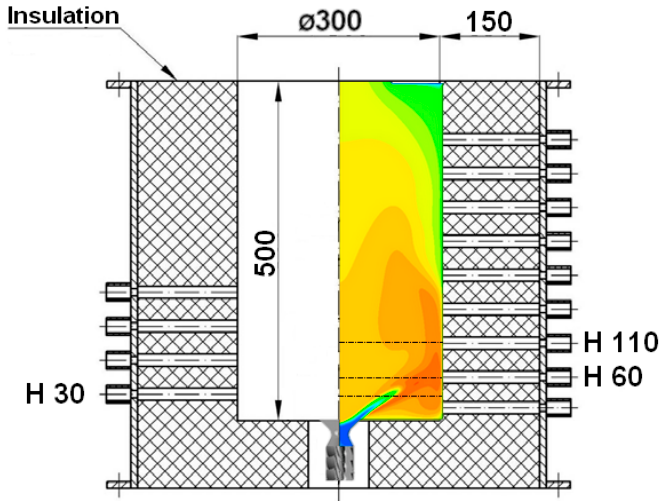
Figure 2. The experimental combustion chamber and the distribution of measurement levels.